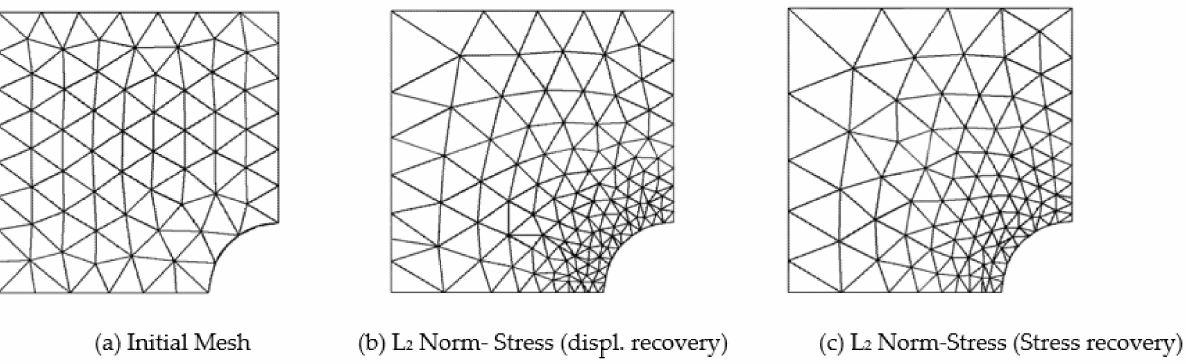
Figure 8. Adaptive mesh required for 1% target error (L 2 -Norm) in compressible elastic square plate with circular inclusion example solution variables considering displacement and stress recovery techniques (Initial regular quadratic triangular mesh: N = 124, DOF =